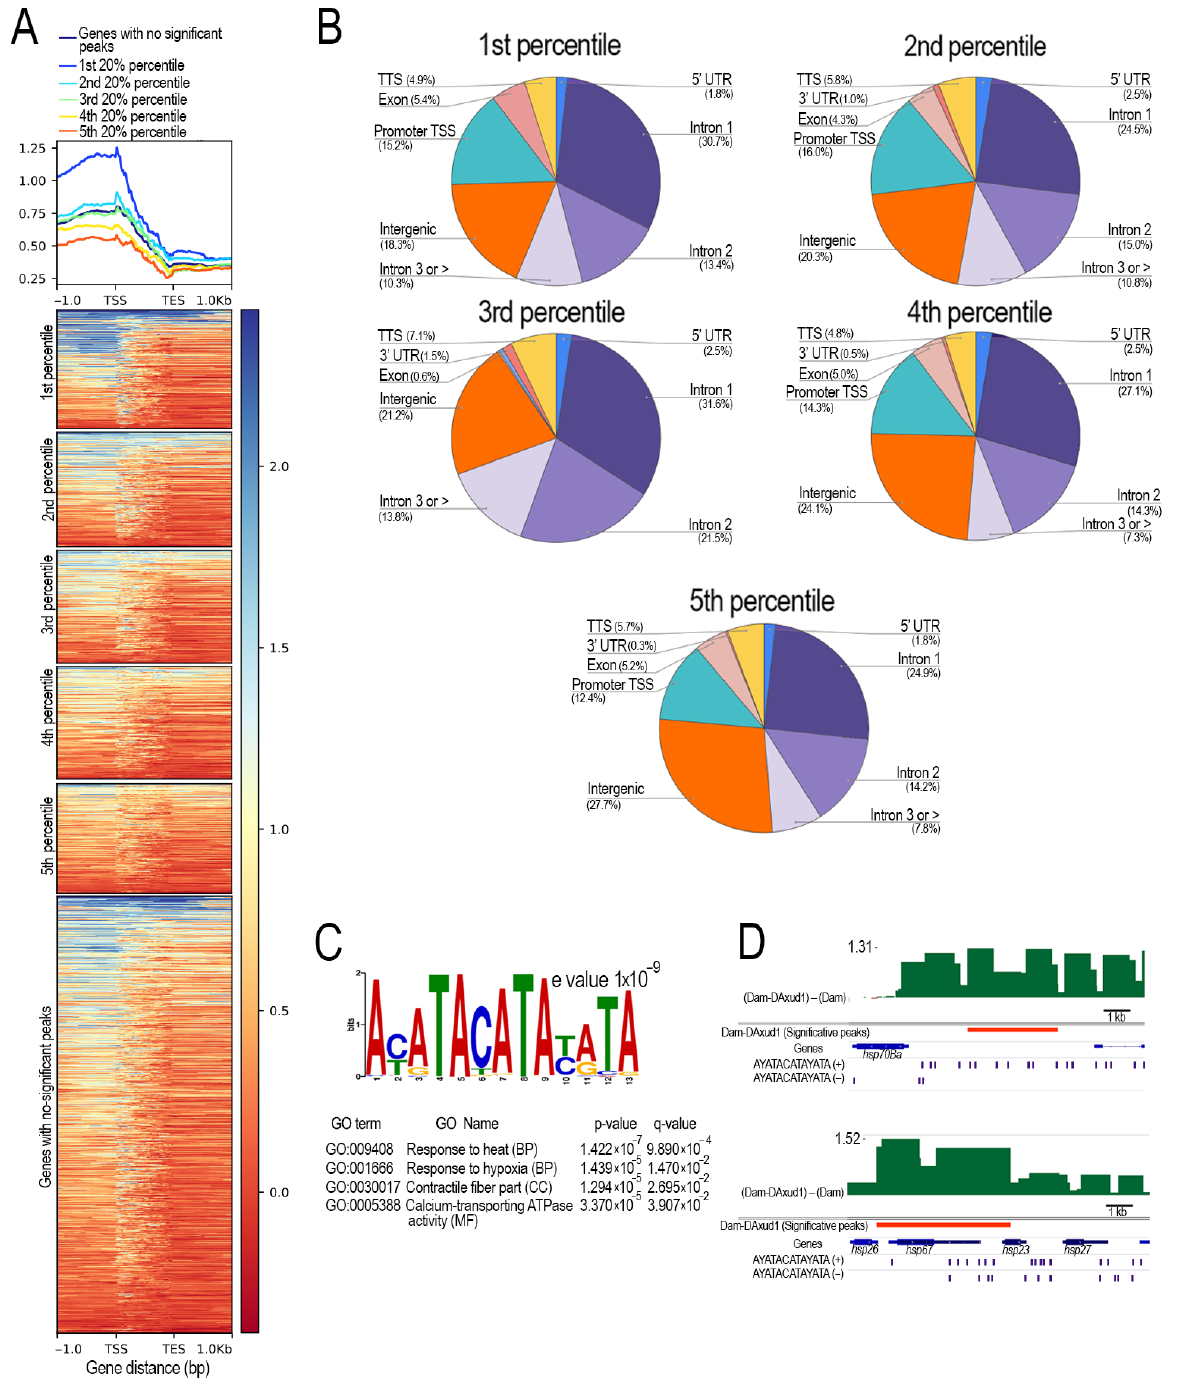
Figure 1. TaDa-seq results from Dam-DAxud1/Dam normalization show the genome-wide location and main motif in the identified significant binding zones. With the Dam/DAxud1 pipeline, a total of 1903 peaks were identified as significant over the background via signal subtraction (Dam-DAxud1 and Dam (no fusion)). These peaks were then annotated with HOMER. ( A ) In the upper zone, a metagene profile is depicted, with Dam-DAxud1 signal (subtraction) with all genes scaled to 1 kilobase. The profile represents the average of the signal every 10 bp bin size, with colors according to their percentile, from the first (1st) with the highest enrichment to the last (5th) for all genes with significant peaks surrounding its region ( − 1 kb TSS to + 1 kb TTS). Gene regions without significant regions are in dark blue. At the bottom of this figure are the heat maps for genes with regions that